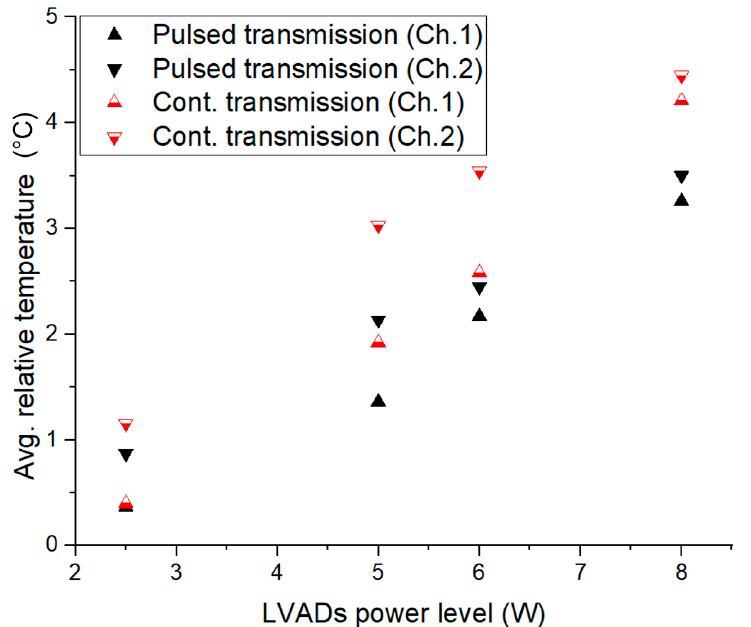
Figure 10. Average relative temperature change ( Δ T) in the subcutaneous tissues vs. power delivered to the load in pulsed and continuous transmission protocols from the in vivo measurements with power levels of 2.5 W, 5 W, 6 W, and 8 W.